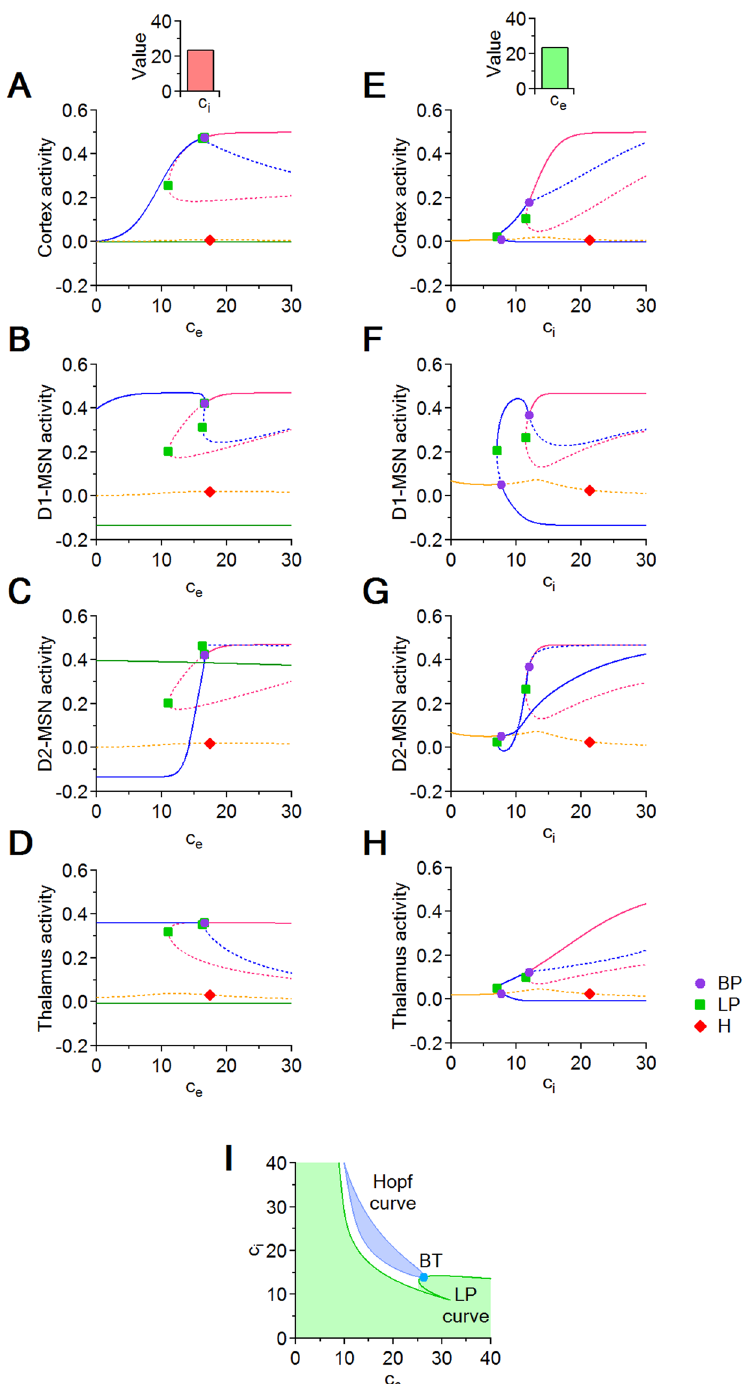
Figure 3. Bifurcation diagrams with respect to c e and c i and bifurcation curves in the ( c e , c i ) parameter plane. ( A – H ) Each panel shows multiple equilibrium curves for the cortex ( A , E ), D1-MSNs ( B , F ), D2-MSNs ( C , G ) and the thalamus ( D , H ). Each curve is drawn with a solid line where the corresponding equilibrium is stable, and with a dotted line where the equilibrium is unstable. Panels (A–D) are obtained by varying only c e while keeping c i = 24. Panels (E,F) are obtained by varying c i while keeping c e = 24. The equilibrium curves show that the system has multistability windows for most values of c e and c i . In each panel, the symbols represent codimension one bifurcation points: branch point (BP, purple circle), limit point (LP, green square), Hopf point (H, red diamond). ( I ) Local bifurcation curves in the ( c e , c i ) parameter plane. The blue loop represents a Hopf bifurcation curve, which delimits a regime of oscillations (blue area) from a regime of convergence to a steady state (white and green areas). The green curve is an LP curve, along which two equilibria (in the region to the right of the green curve) collide and disappear (in the region to the left of the green curve). The Hopf and the LP curves touch at a Bogdanov-Takens (BT) codimension two bifurcation